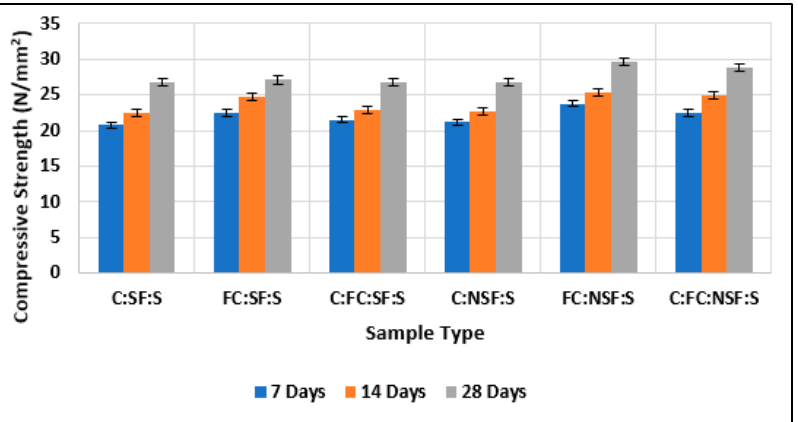
Figure 14. Comparison of test results of cubes with cement, fine cement, and silica fume with test results of cubes with cement, fine cement, and nano-silica fume.